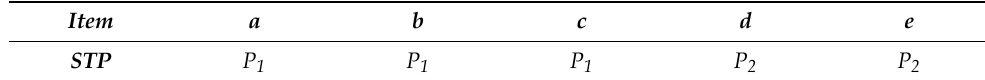
Table 3. The STP of all items for the running